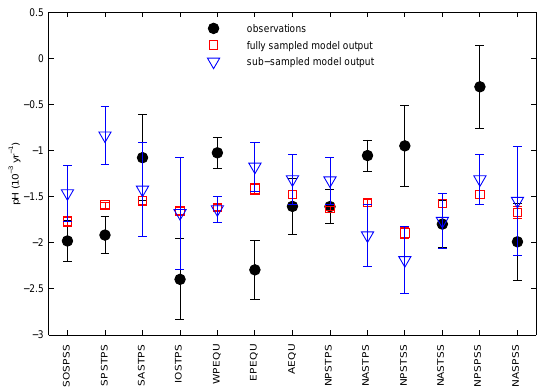
−3 Figure 5 Figure 5. Summary of the pH trends in all biomes. The error bars show the 1 σ confidence